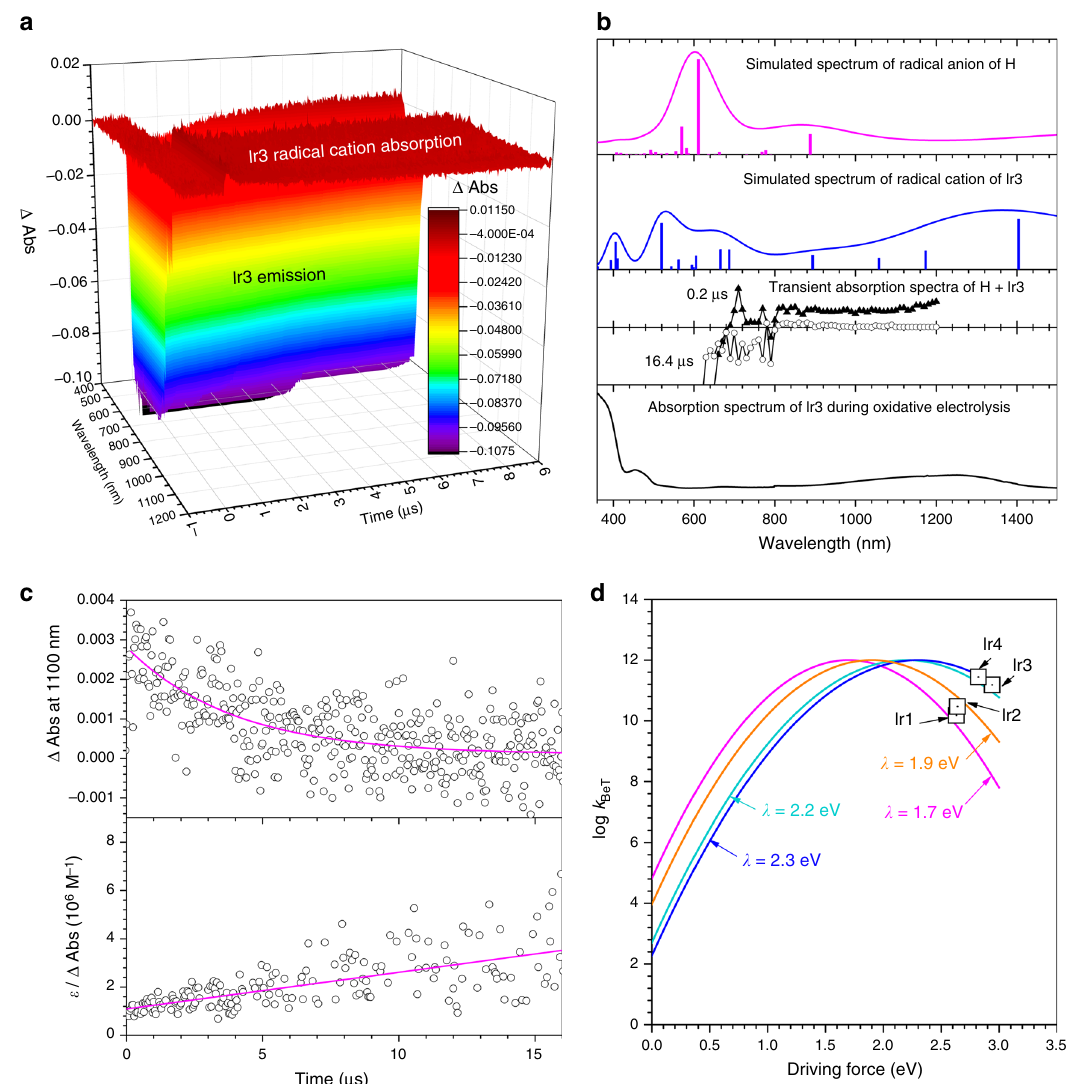
Fig. 4 Annihilation of radical ion pairs. a Transient absorption spectra of a THF solution containing 150 μ M Ir3 and 3.0 mM H after nanosecond pulsed photoexcitation. The negative and positive absorbance were due to the emission of Ir3 and the generation of Ir3 (cid:129) + , respectively. b Comparisons of the simulated (TD − B3LYP) electronic transition spectra of the radical anion of H (magenta curve) and the radical cation of Ir3 (blue curve) with the transient absorption spectra obtained at delay times of 0.2 μ s (black triangles) and 16.4 μ s (empty circles), and the absorption spectrum of Ir3 obtained during oxidative electrolysis at 1.30 V vs. SCE (black curve). c Decay traces (top panel) and a second-order plot (bottom panel) of the transient absorption signals observed at a wavelength of 1100 nm. d Plot of the rate constant for back electron transfer for charge recombination ( k BeT , black squares) as a function of the driving force and the Marcus plots for outer-sphere electron transfer calculated for the reorganization energies ( λ ) at 1.7 eV (magenta), 1.9 eV (orange), 2.2 eV (turquoise), and 2.3 eV (blue). The Marcus plots were constructed from the equation, k BeT = Z exp[ − ( Δ G BeT + λ ) 2 /4 λ k B T ]. In this equation, Z , k B , and T are the collisional frequency taken as 1.0 × 10 12 M − 1 s − 1 , the Boltzmann constant, and absolute temperature (298 K),